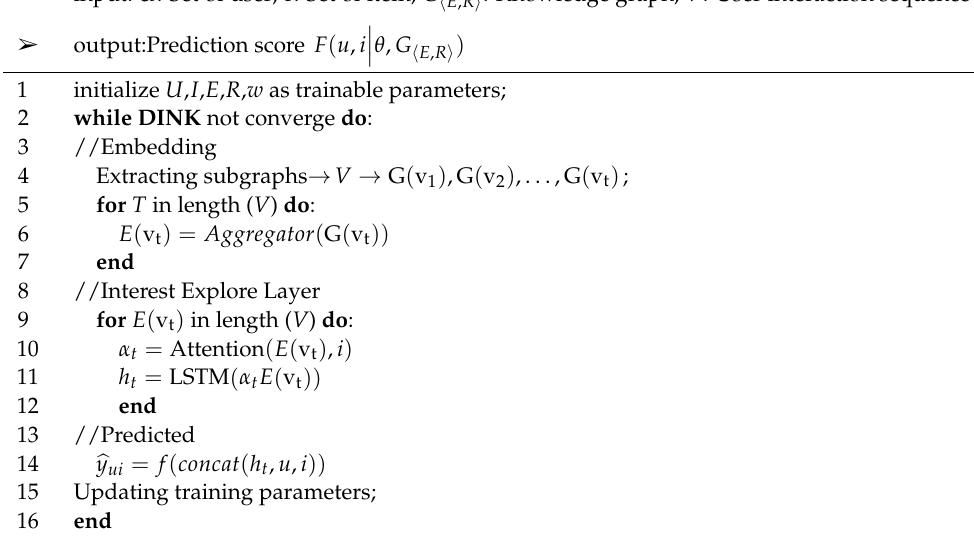
Algorithm 1: DINK